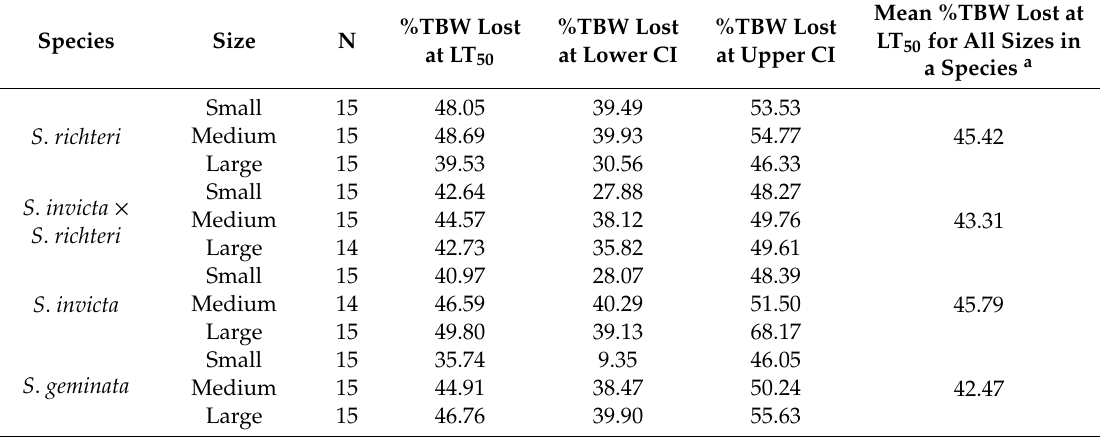
Table 4. Percentage of total body water (%TBW) lost at median time of death; at lower and upper confidence intervals (CI) for live small, medium, and large workers of S . richteri , S . invicta × S . richteri , S . invicta , and S . geminata desiccated at 30 ◦ C and 0–2% RH.